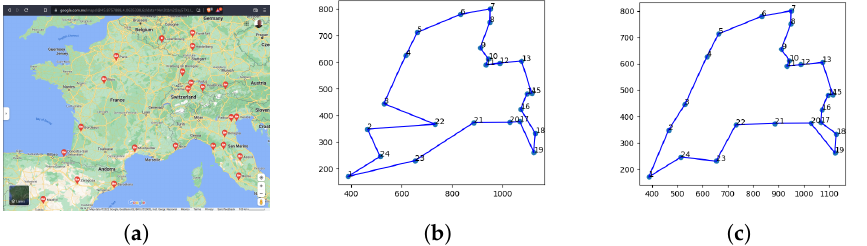
Figure 28. Map and solution of instance “ Europe.tsp ”. ( a ) Map [51]; ( b ) Solution; ( c ) Improved solution.